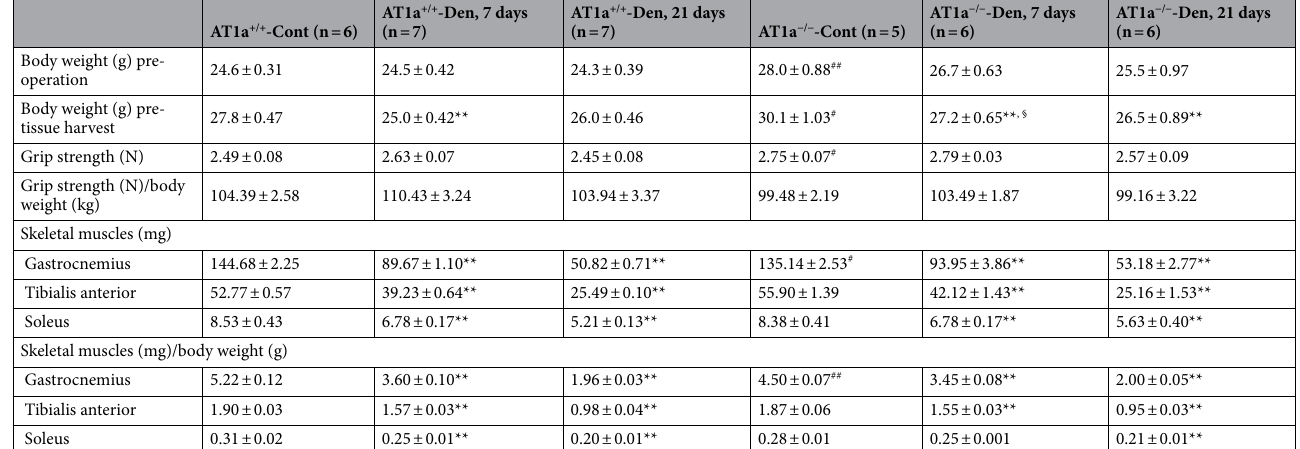
Table 1. Animal characteristics at 7 and 21 days postdenervation. Values are means ± SE. ** P < 0.01 vs the same group control; # P < 0.05 and ## P < 0.01 vs AT1a +/+ -Cont; § P < 0.05 vs AT1a +/+ -Den (7 days).